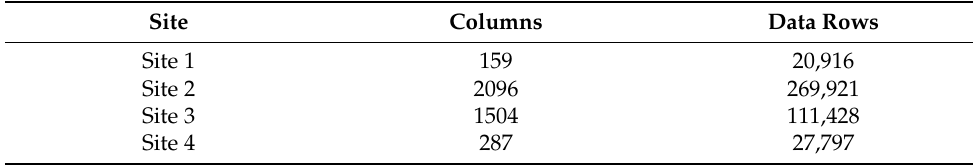
Table 4. Data initially available.